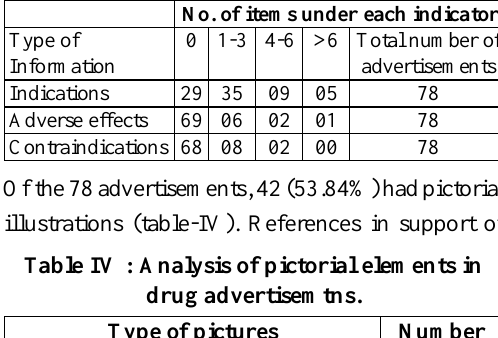
Data on indicators in drug advertisements.